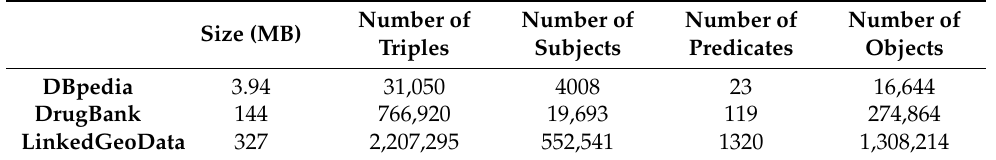
Table 2. Characteristics of the Linked Open Data (LOD) dataset.